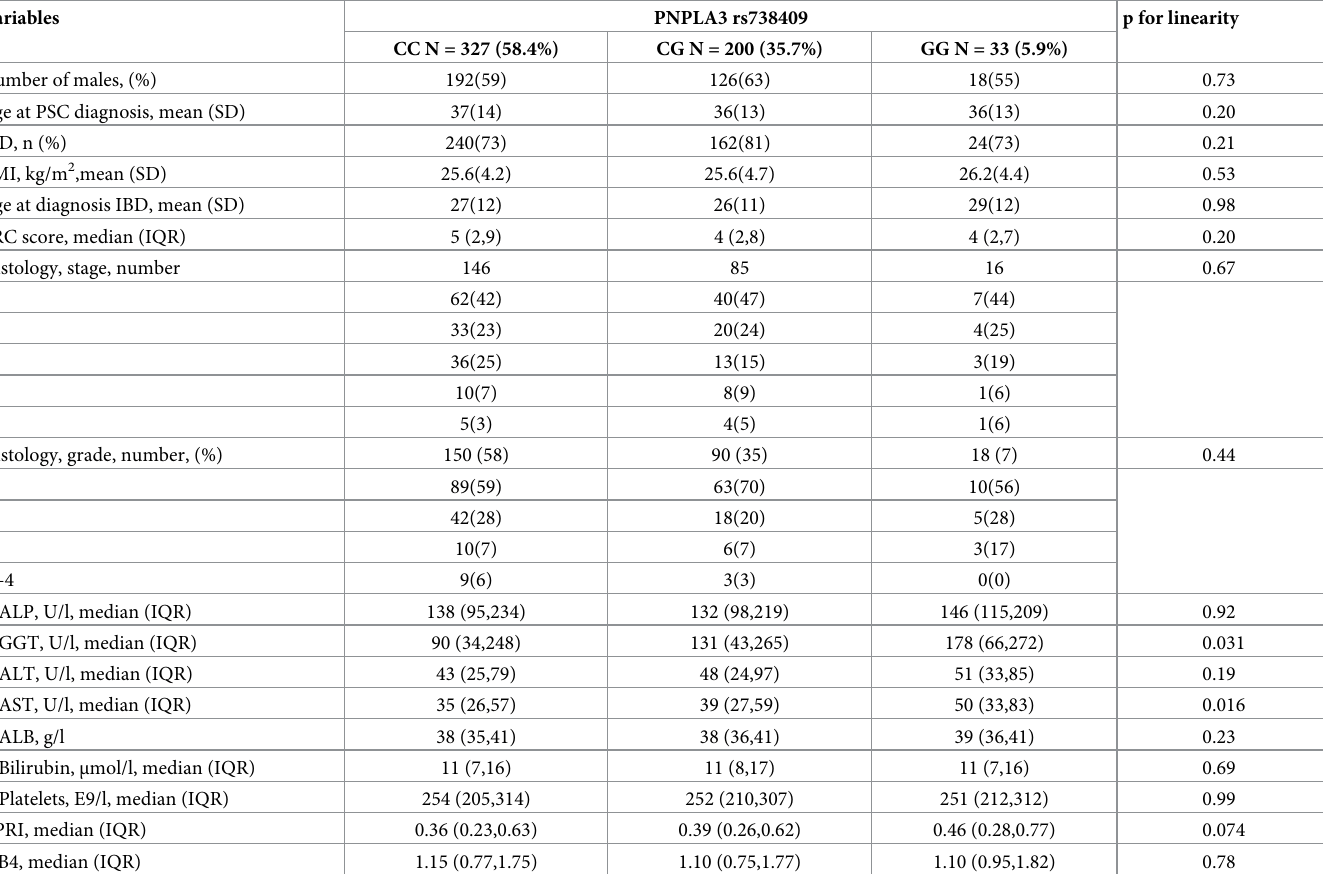
Table 1. Clinical characteristics of patients based on PNPLA3 haplotype.